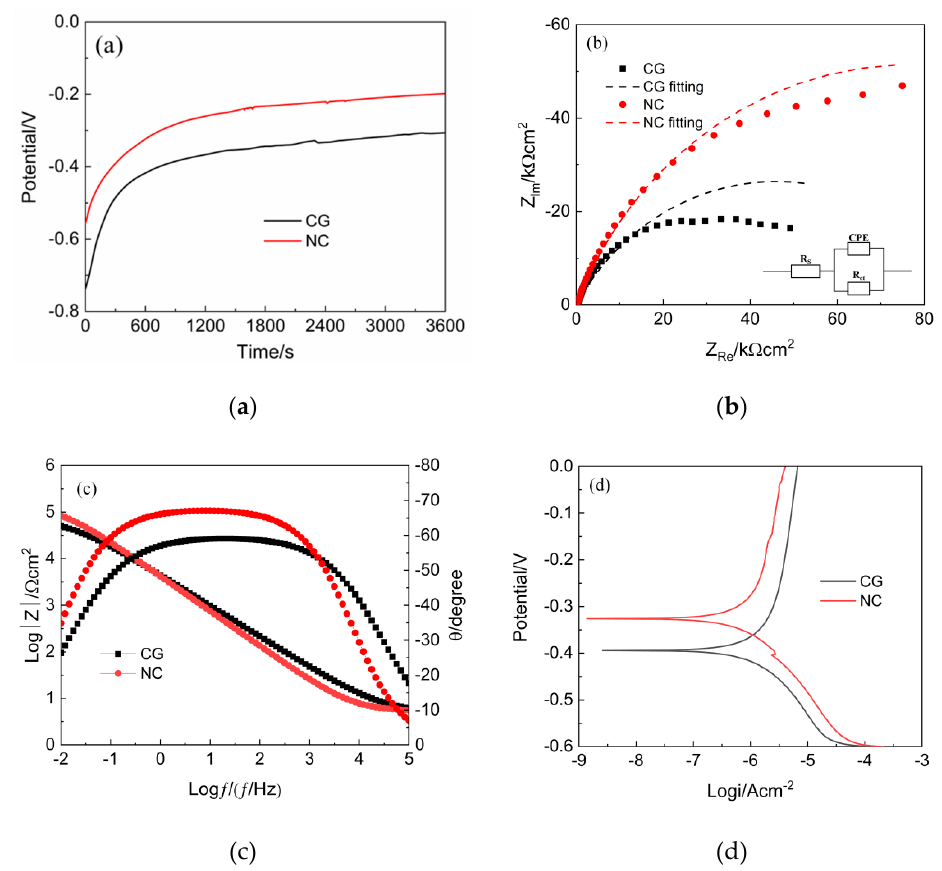
Figure 6. Corrosion behavior of alloy 690 before and after USRT. ( a ) open circuit potential (OCP) curves, ( b ) Nyquist impedance spectra and corresponding equivalent circuit model ( Rs is the solution resistance, Rct is the charge-transfer resistance, and CPE is the constant phase element), ( c ) Bode diagram, ( d ) potentiodynamic polarization curves. Table 2. Equivalent circuit results obtained from electrochemical impedance spectroscopy (EIS) data fitting.